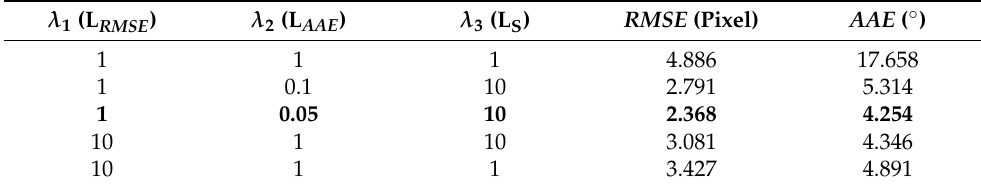
Table 3. Parameter Sensitivity Results of Compound Loss Functions on Limited Data Sets.